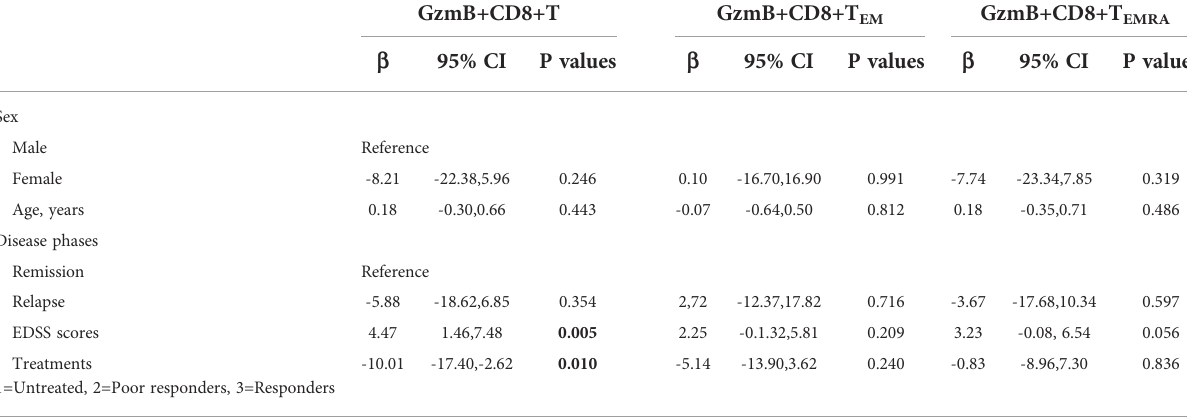
TABLE 2 Associations between GzmB levels in CD8+ T subpopulations and clinical characteristics of NMOSD patients.